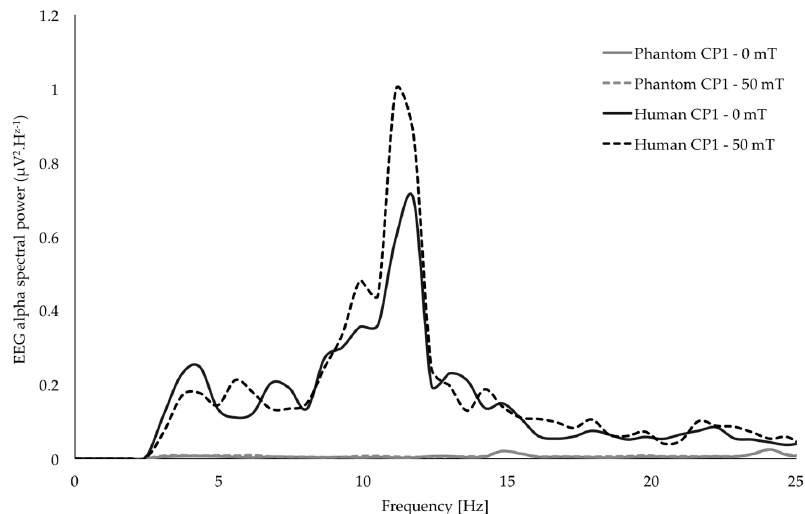
Figure 3. Averaged power spectra for EEG recorded in the CP1 electrode during the 60 Hz exposure, for the 0 and 50 mT rms conditions, in both a phantom and a human (subject 4). Each spectrum is averaged over five repetitions at the corresponding flux density condition. This illustration shows an absence of potential contamination of the EEG in the 3–25 Hz range due to the exposure.